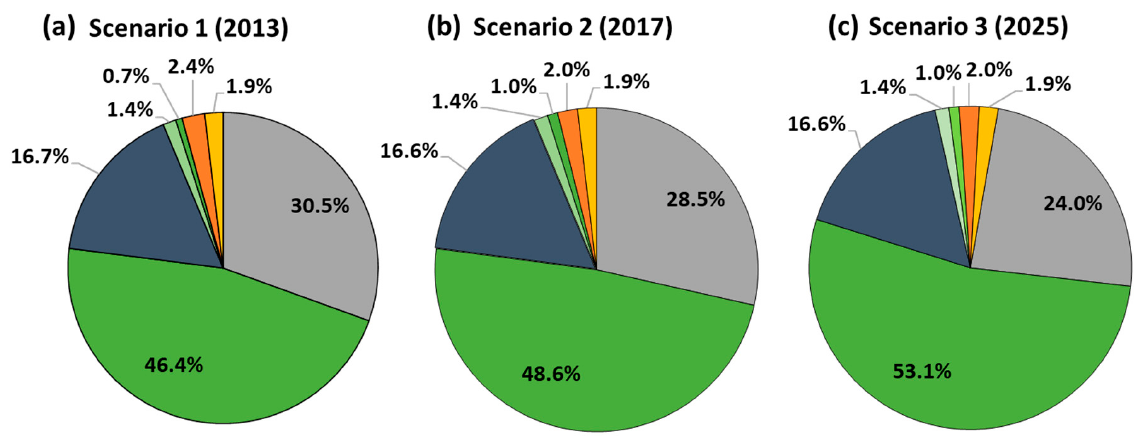
Figure 4. Land-use proportion for ( a ) scenario 1: before planting (2013), ( b ) scenario 2: after planting 1 billion trees (2017), and ( c ) scenario 3: after planting 3 billion trees (2025). Here, BARR—barren, FRST—forest-mixed, GLAC—glaciers, AGRL—agricultural land-generic, FRSE—forest-evergreen, RNGB—range-brush, RNGE—range-grasses.